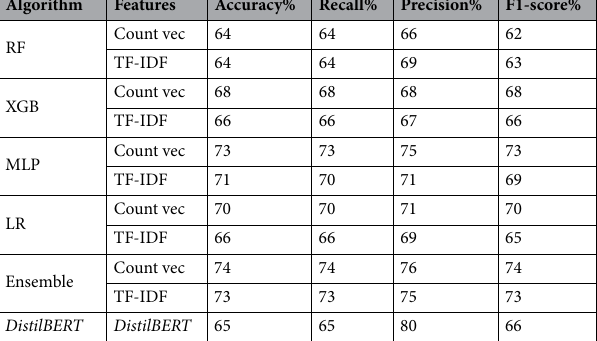
Table 7. All Feature Extraction and algorithm Results for Article3 Dataset with 20 Authors.